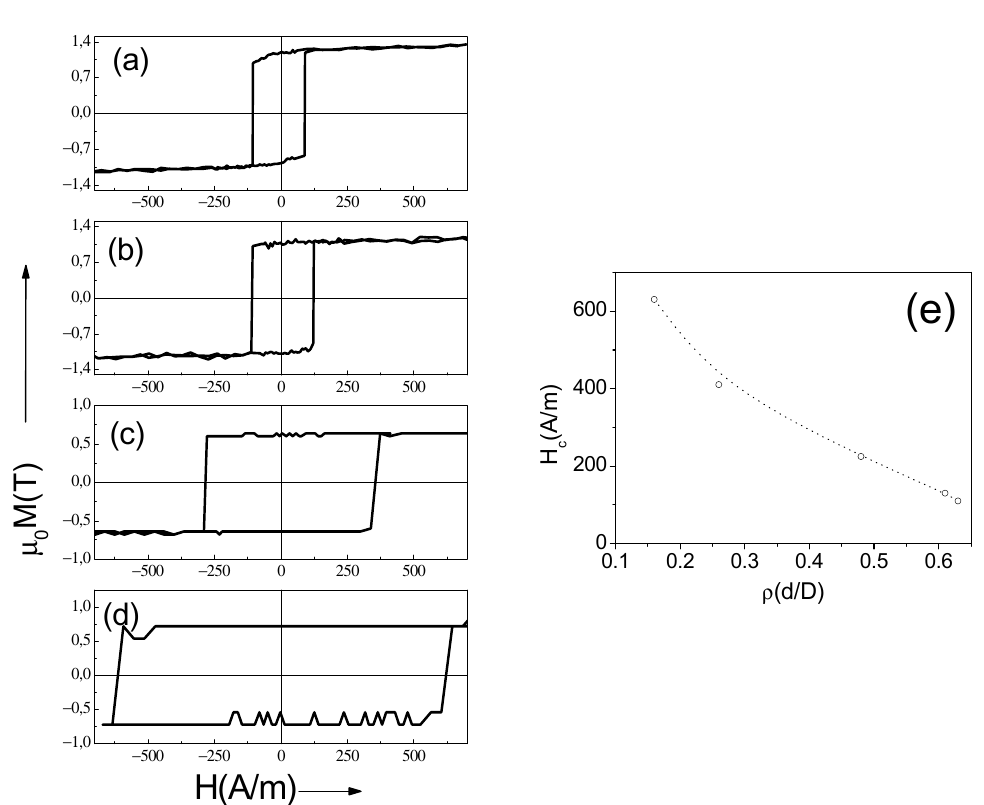
Figure 7. Hysteresis loops of Fe 70 B 15 Si 10 C 5 amorphous microwires with different metallic nucleus diameter d and total diameters D : with ρ = 0.63; d = 15 µ m ( a ); ρ = 0.48; d = 10.8 µ m ( b ); ρ = 0.26; d = 6 µ m ( c ); ρ = 0.16; d = 3 µ m ( d ) and H c ( ρ ) dependence of the same microwires ( e ). Adapted from [78].